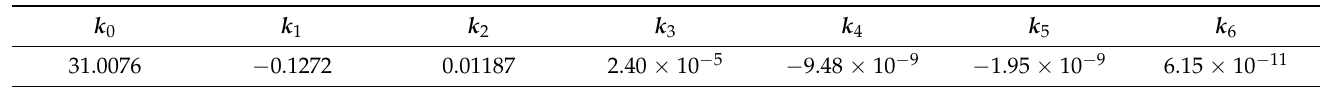
Table 3. Polynomial coefficient to retrieve the mean solar angle as a function of the MGRS tile latitude (NASA HLS, [48]).